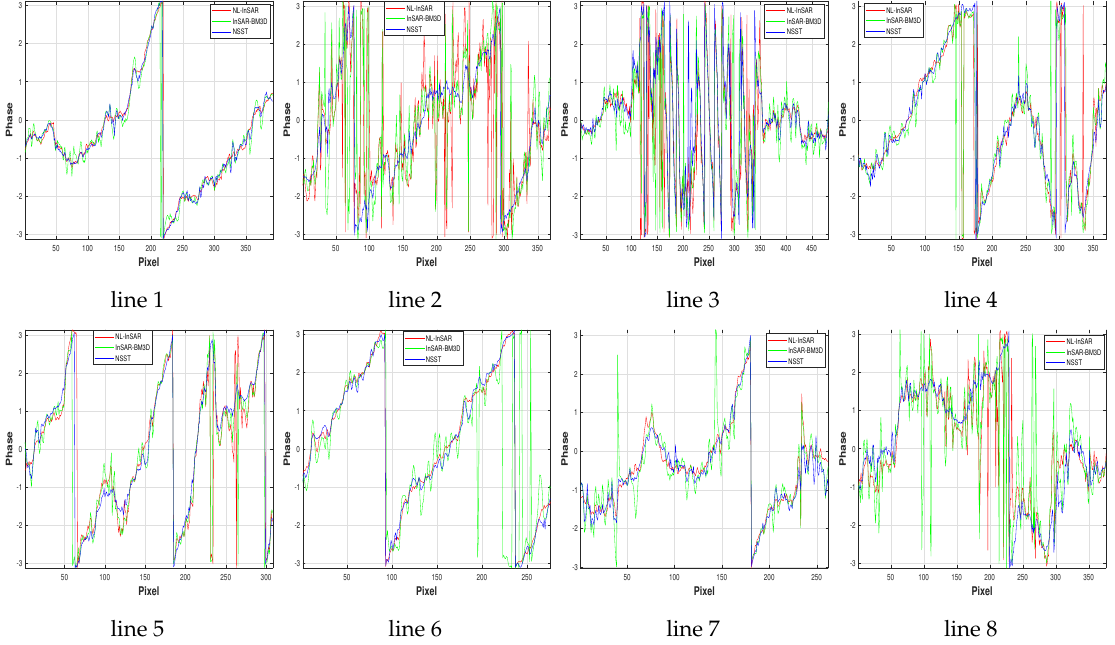
Figure 17. The phase profile of white lines in Figure 16 (the red, green and blue solid line represent the result of NL-InSAR, InSAR-BM3D and NSST,